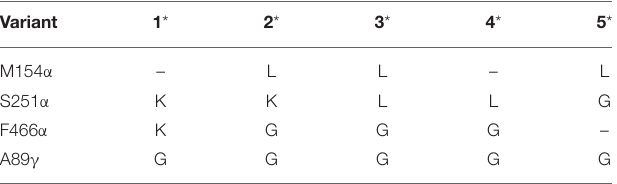
TABLE 2 | Top five variants of CS2, sorted by interaction energy between the enzyme and grafted transition state.